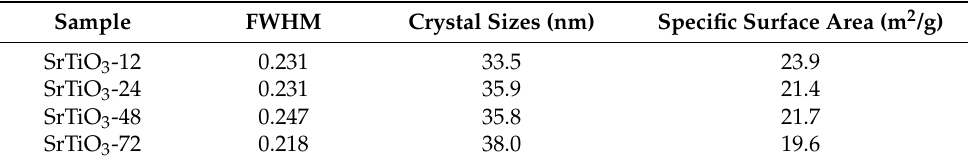
Table 1. Physical parameters of the samples prepared at different hydrothermal durations.